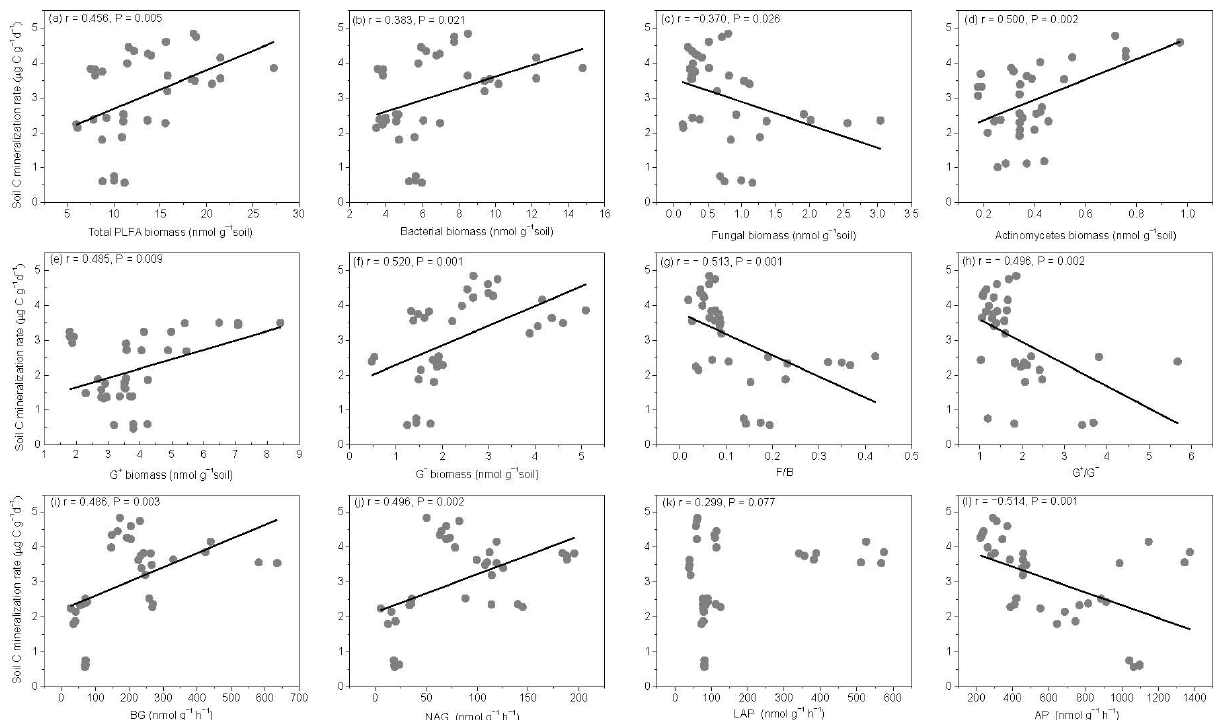
Figure 7. Relationships between soil carbon mineralization rates (µgCg − 1 d − 1 ) and different groups of soil microbial PLFAs (a–h) and enzyme activities (i–l)